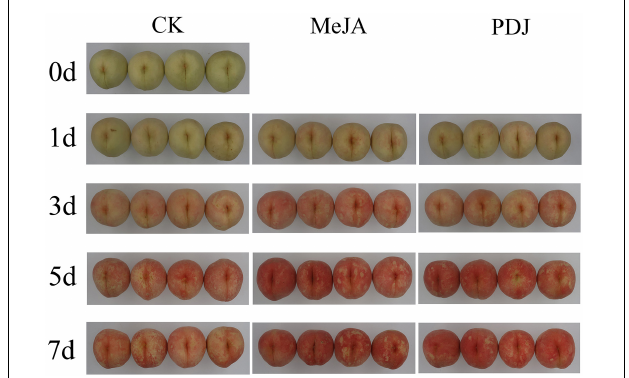
FIGURE 1 | Effects of postharvest jasmonate treatments on visual color development in the skin of peach fruits during storage (22 ± 2 ◦ C; light intensity 300–400